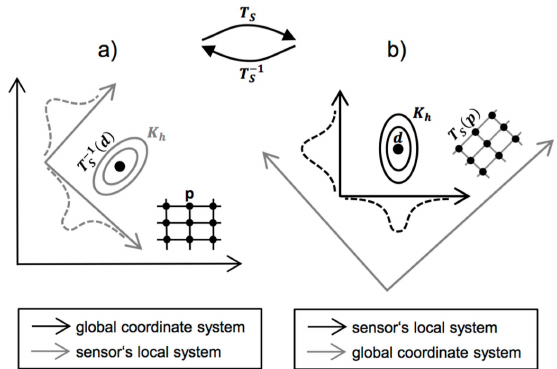
Figure 3. Coordinate transformation during the computation of the fused density. The two black coordinate systems in ( a , b ) are related through the coordinate transform T s . ( a ) Coordinate system in which the fused density will be evaluated at gridded points p . The coordinate systems of the individual sensors, where the hits d are defined, are not axis-aligned with the global system. In particular, the kernels K h would require non-diagonal bandwidth matrices; ( b ) Coordinate system of one of the sensors, given by its measurement grid. For single-sensor density estimation, kernels K h are axis-aligned to the sensor’s system, thus facilitating product kernels. The single-sensor density is then evaluated at the transformed points T S p p q